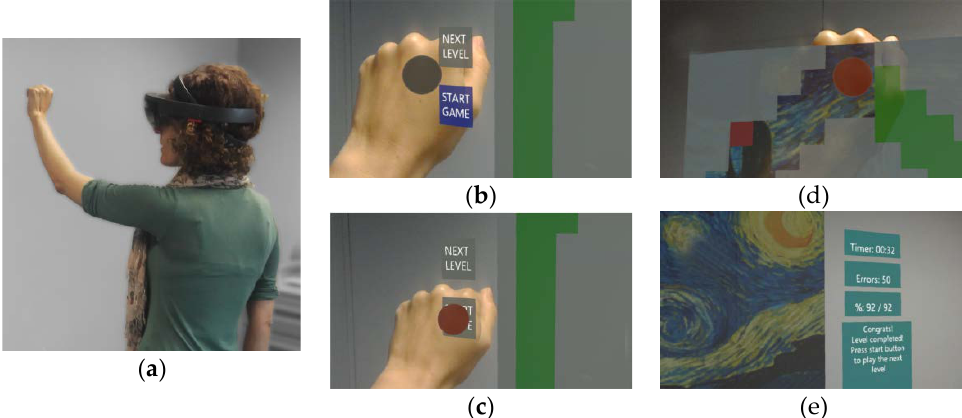
Figure 5. Photos during the testing of the system: ( a ) a subject performing the AR rehab game, ( b , c )